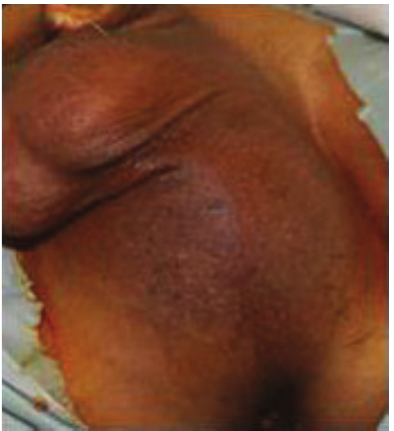
Figure 1: Perineal bulge produced by